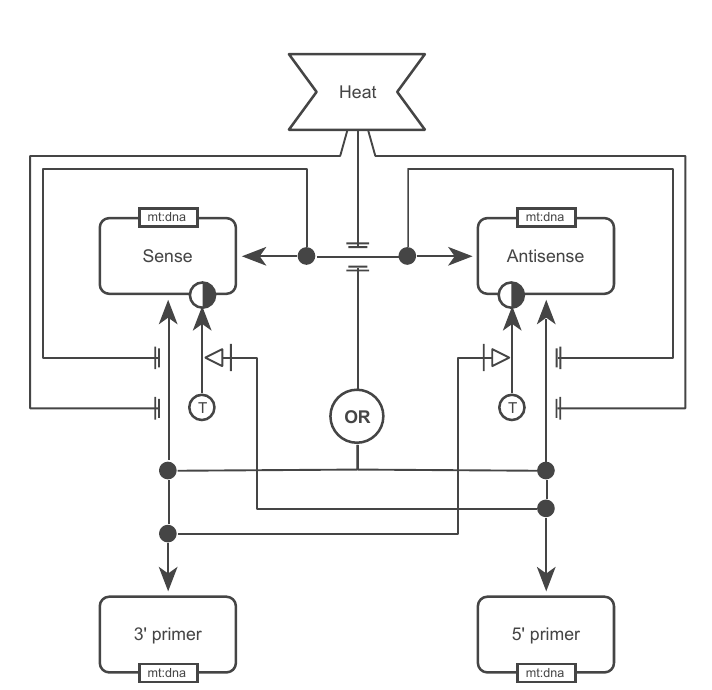
Figure 28: Principle of the Polymerase Chain Reaction (PCR) (Mullis et al.,